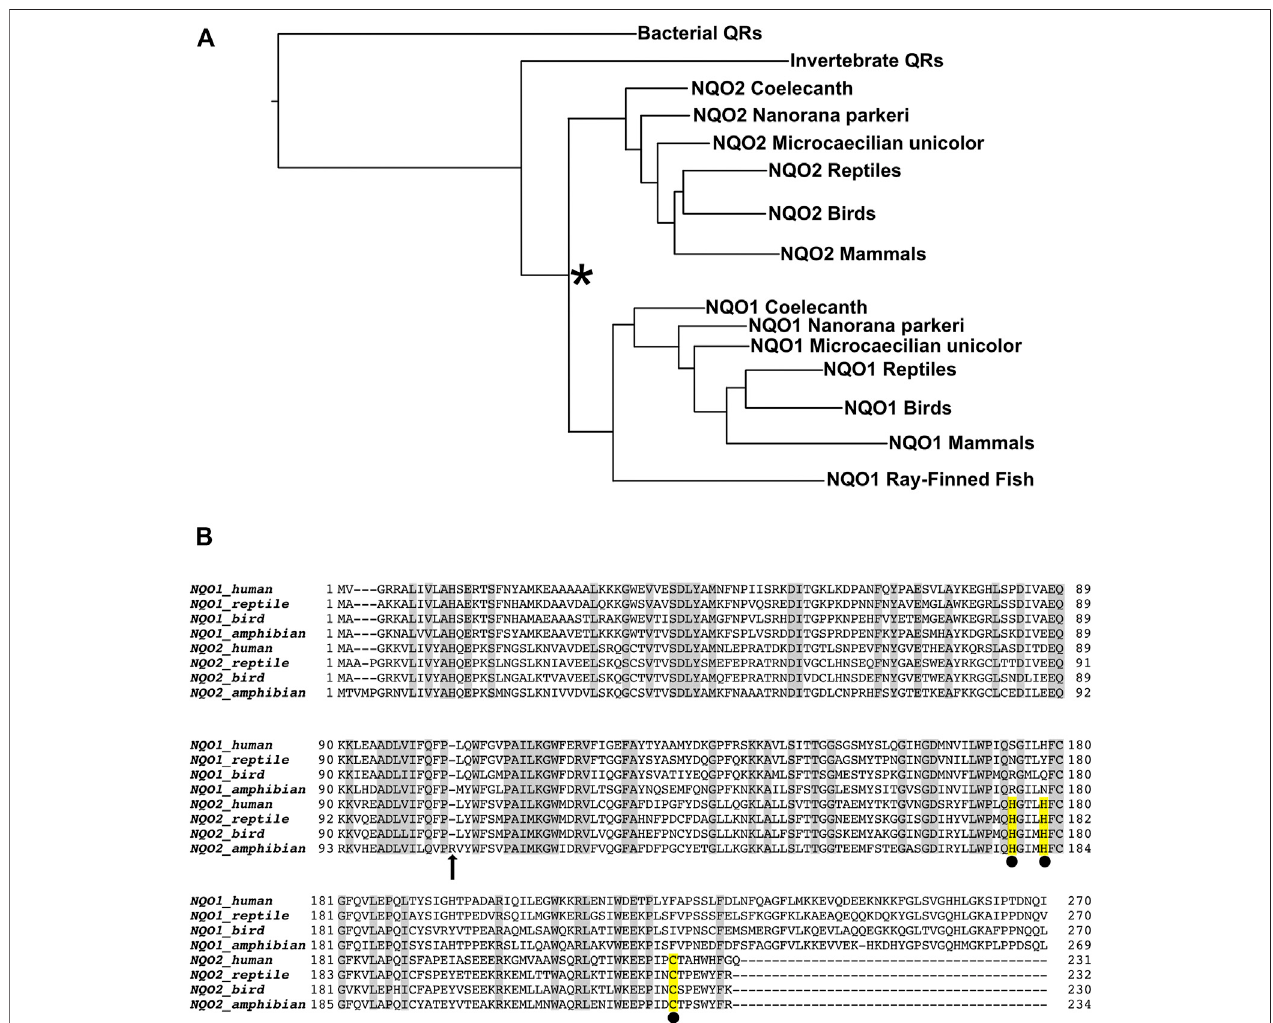
FIGURE 3 | Evolution of Quinone Reductases. (A) Simpli fi ed phylogenetic tree calculated from 172 unique quinone reductase sequences. Duplication of an NQO gene (indicated by the asterisk) occurred in an ancient vertebrate fi sh ( Euteleostomi ) to produce the NQO1 and NQO2 enzyme families. The Euteleostomi then diverged into subgroups Actinopterygii , which includes extant ray- fi nned fi shes, and the Sarcopterygii that includes the tetrapods. NQO1 is present in all vertebrates, whereas NQO2wasapparentlylost intheray- fi nned fi shes,which haveonly theNQO1 gene.NQO2 ispresent inthelobe- fi nned fi sh, Latimeria chalumnae (coelacanth)and someamphibiangenomes,includingtheHighHimalayanfrog, Nanoranaparkeri, and Microcaeciliaunicolor .NQO2isalsopresentinalltheamniotes,namelythereptiles, birds, and mammals. (B) Sequence alignment of extant NQO1 and NQO2 enzymes from human and representative reptile ( Alligator mississippiensis ), bird ( Anas platyrhynchos ) and amphibian ( Nanorana parkeri ). The most prominent differences between the enzymes are the conserved C-terminal extension of NQO1, and the conserved metal binding site of NQO2, indicated by the yellow highlighted residues with black spheres underneath. Both the reptile and bird NQO2 sequences have beenexpressedin E.coli ,puri fi ed,andcharacterized,whereasNQO2from Nanoranaparkeri couldnotbeexpressedasarecombinantproteindespiteseveralattempts. We believe the enzyme from N. parkeri is no longer functional due to residue changes, including insertion of arginine (indicated by the arrow at position 107) in a highly conserved region that interacts directly with the isoalloxazine of